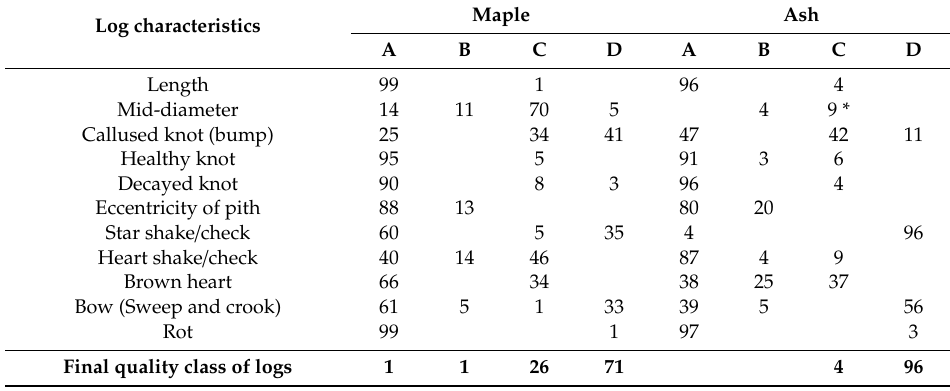
Table 6. Yields in % for quality sorting of logs according to DIN 1316-3 [30] separated after sorting criteria (log